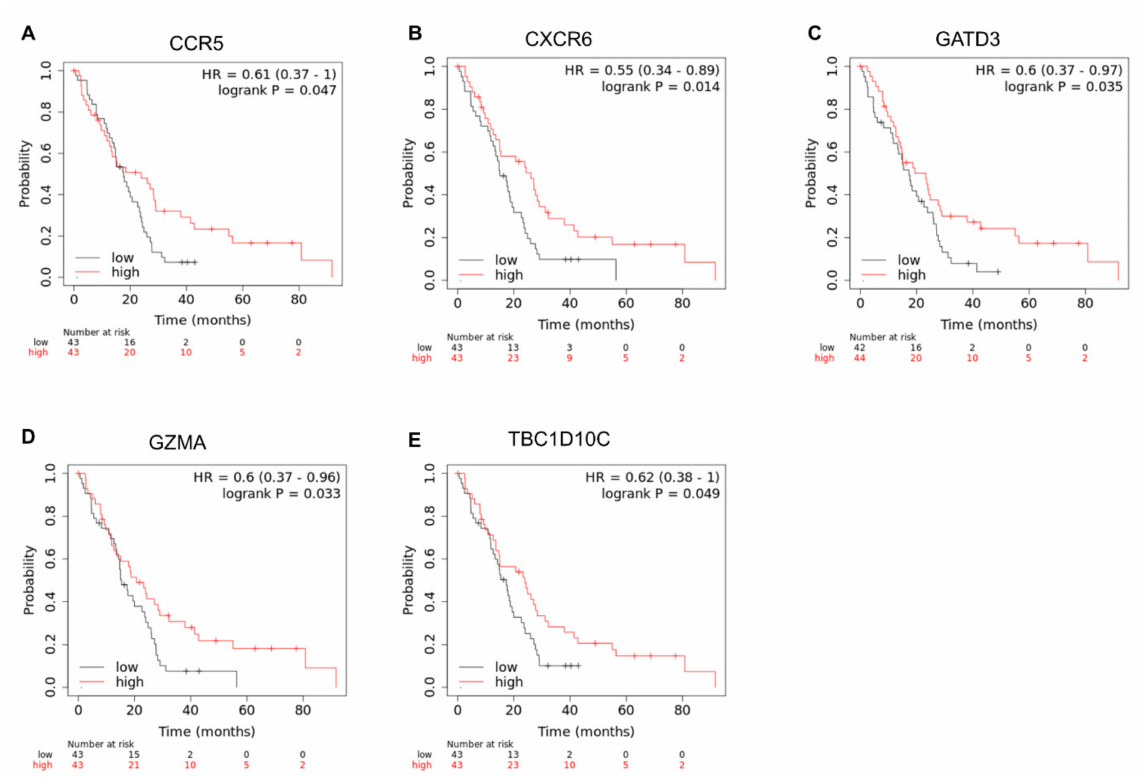
Figure 2. Statistically significant Kaplan − Meier plots for CD274 , PDCD1 , and 40 PDCD1/CD274 - related genes. Only statistically significant survival curves are shown. For each graph above ( A – E ), the overall survival in months can be seen on the x -axis, whereas the probability of survival is shown on the y -axis. Hazard ratio (HR) and logrank p value for the analysis is indicated. High expression of CCR5 ( A ), CXCR6 ( B ), GATD3A/GATD3 ( C ), GZMA ( D ), and TBC1D10C ( E ) is shown in red, whereas low expression for each gene is shown in black. Data were generated using the mRNA expression z-scores relative to diploid samples (RNA Seq V2 RSEM) for the Mesothelioma (TCGA, PanCancer Atlas) study [15] available on cBioPortal, and Kaplan–Meier analysis was performed via Kaplan–Meier